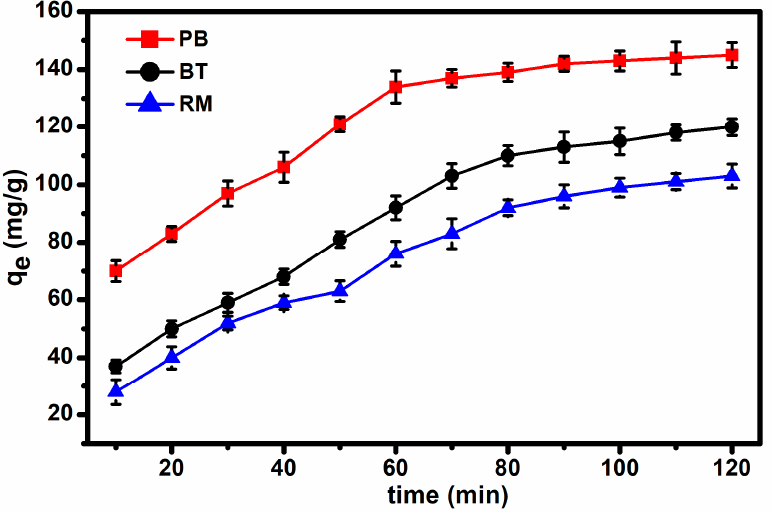
Figure 8. Effect of contact time on malachite green (MG) adsorption.